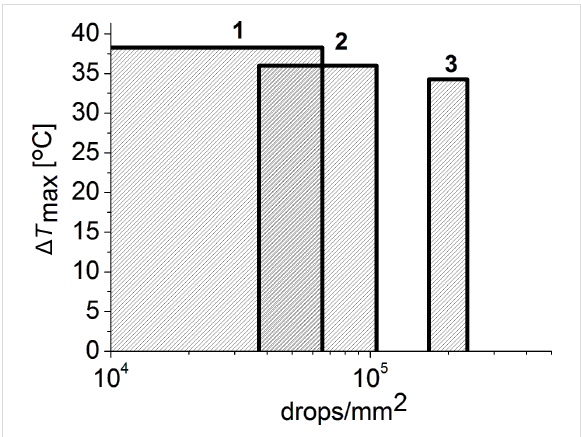
Figure 4: Comparison of the different ink amounts needed to reach similar photothermal effect ( Δ T ≈ 35 °C) of on GNS patterns printed onto three differently coated paper substrates: non-permeable (1); semi-permeable (2), and permeable (3). The laser intensity was 0.36 W/cm 2